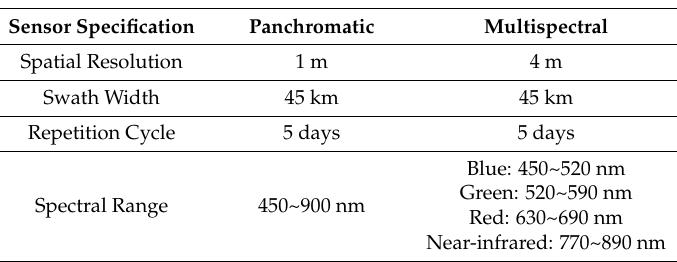
Table 2. The GaoFen2 satellite images used for the detection of buildings in this study.